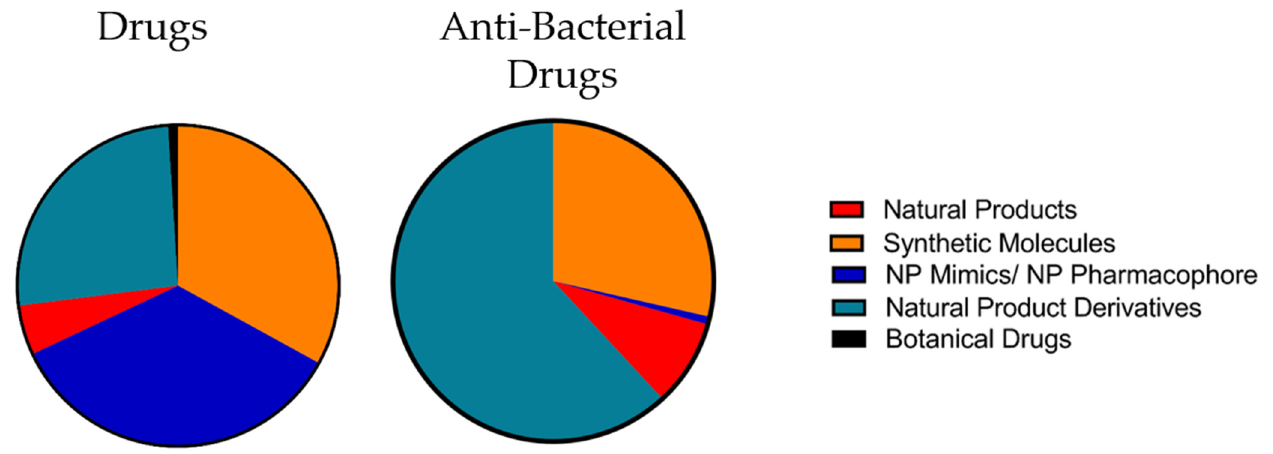
Figure 4. Origin of small molecular drugs from Jan. 1981 to Sept. 2019. To the left, drugs over all indications are grouped, and to the right, specifically the anti-bacterial drugs are grouped for comparison. Numbers from Newman and Cragg [45]; the classifications from the original were pooled for simplification.